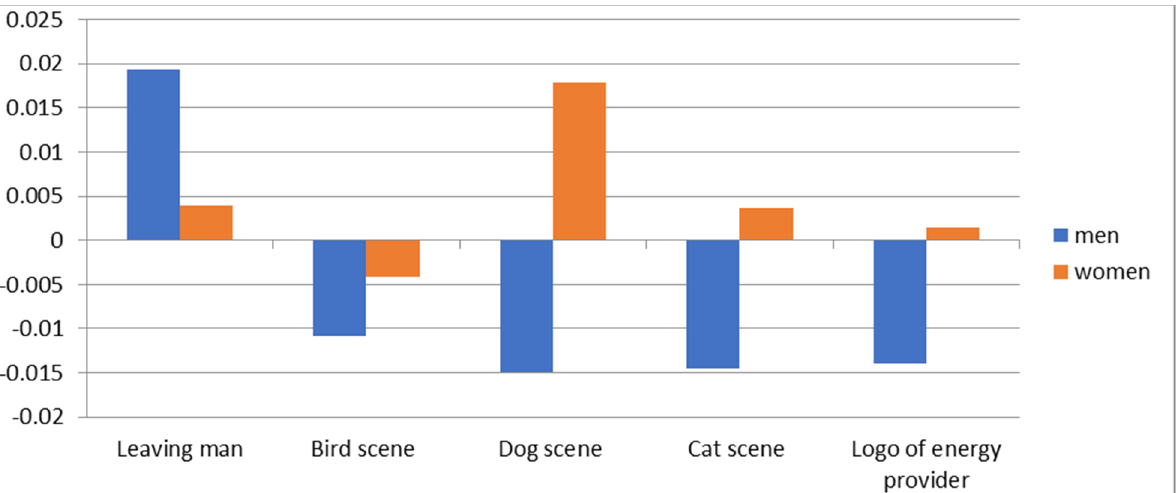
Figure 9. Average values of the normalized male and female engagement indices for the Energa media message.